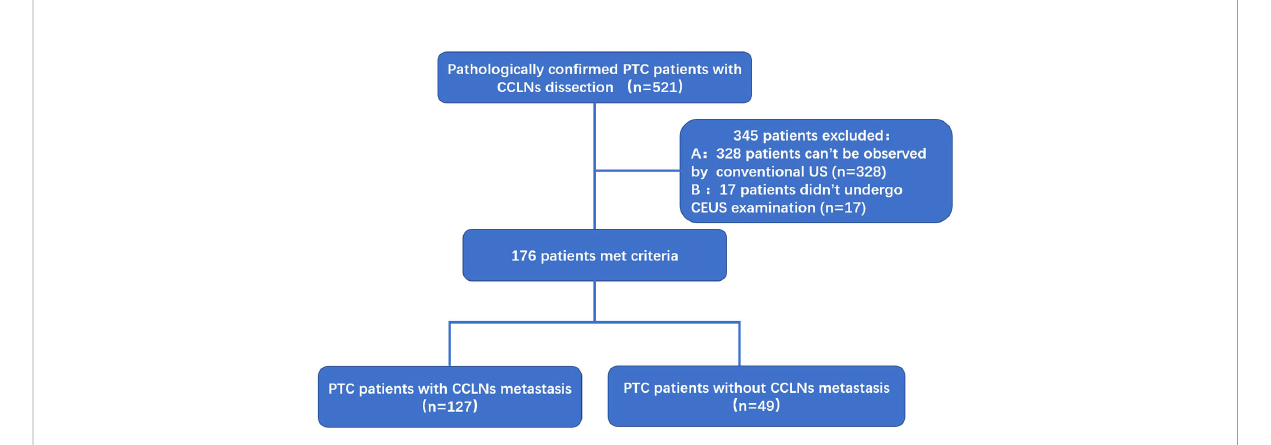
FIGURE 1 Flowchart for the selection of patients with PTC. PTC, papillary thyroid carcinoma; CCLNs, Central cervical lymph